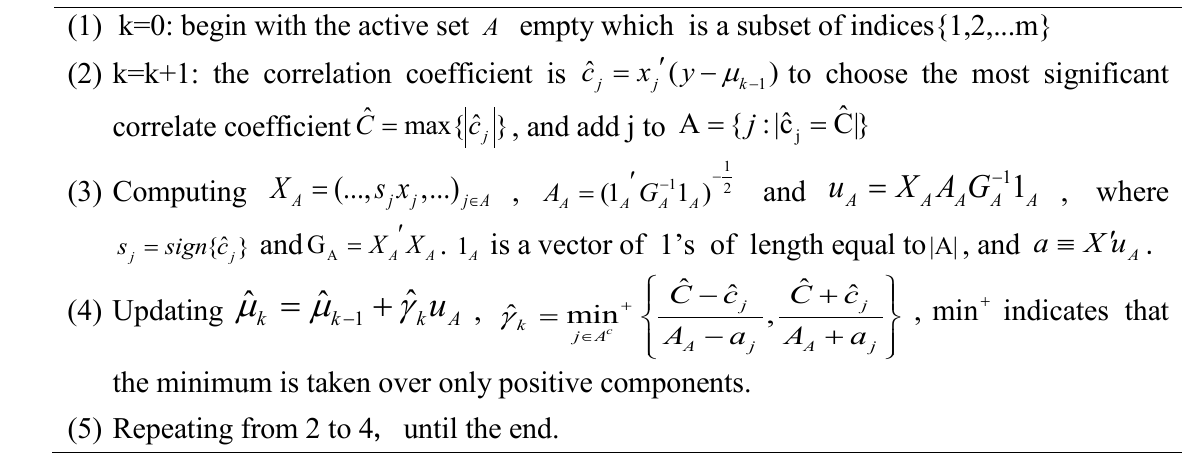
Algorithm 1. The steps of the LARS